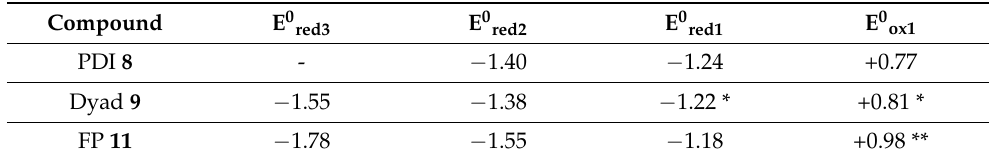
Figure 3. Cyclic voltammogram ( a ) and deconvoluted cyclic voltammogram ( b ) of dyad C 60 -PDI 9 (C = 5 × 10 − 4 M), Pt electrodes, CH 2 Cl 2 / n -Bu 4 NPF 6 (0.1 M). Table 1. Oxidation and reduction potentials of dyad 9 , references PDI 8 , and fullerene 11 . (V vs. Fc + /Fc). Scan rate: 100 mV/s.